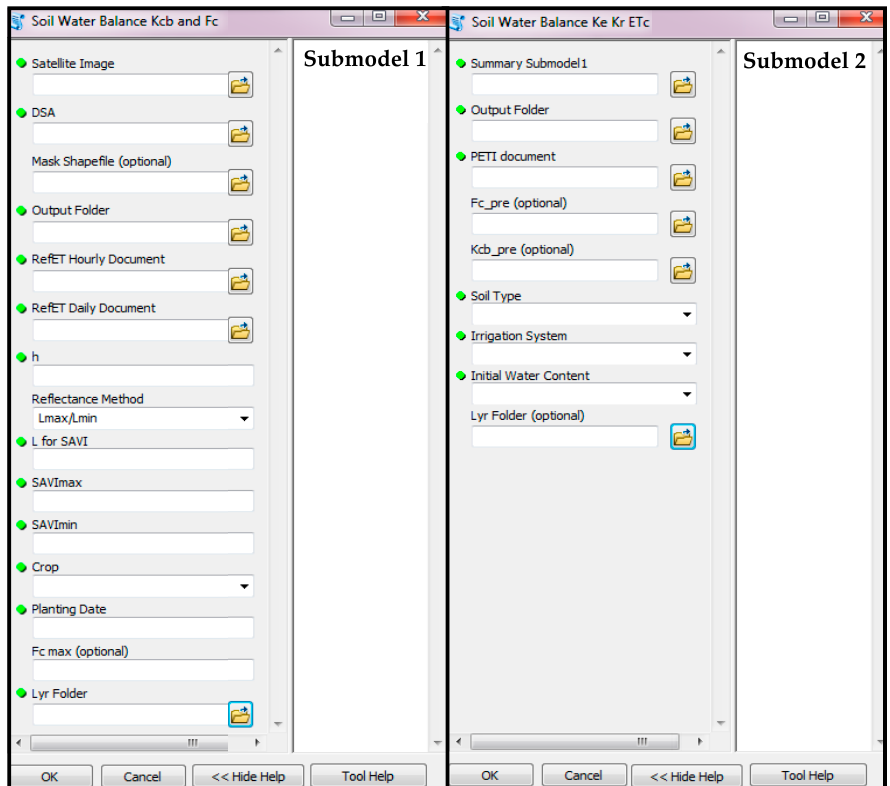
Figure 4. Toolbox interfaces of sub-model 1 ( left ) and sub-model 2 ( right ) implemented in ArcGIS (geographic information system), showing the different input parameters (Table 4 provides explanations for each item). RefET—reference ET; DSA—digital elevation model, slope, and terrain aspect; SAVI—soil-adjusted vegetation index.